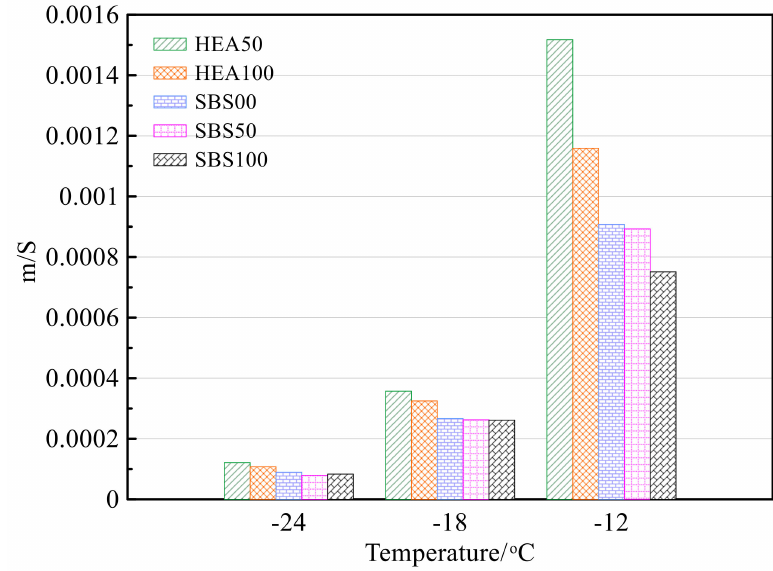
Figure 13. m/S of asphalt